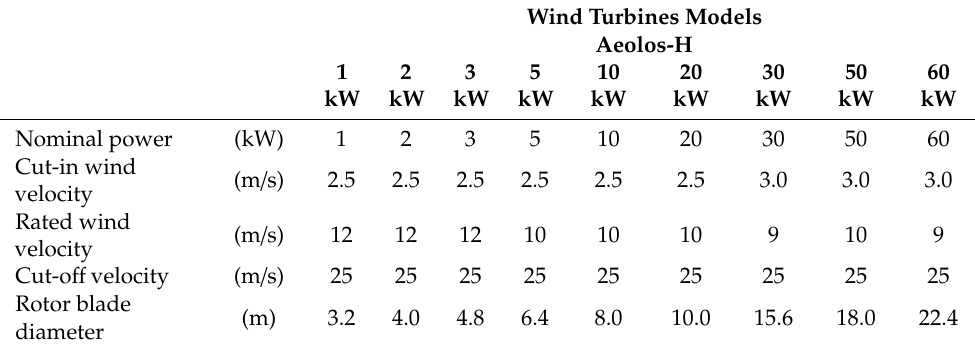
Table 3. Main characteristics of wind turbine (WT)